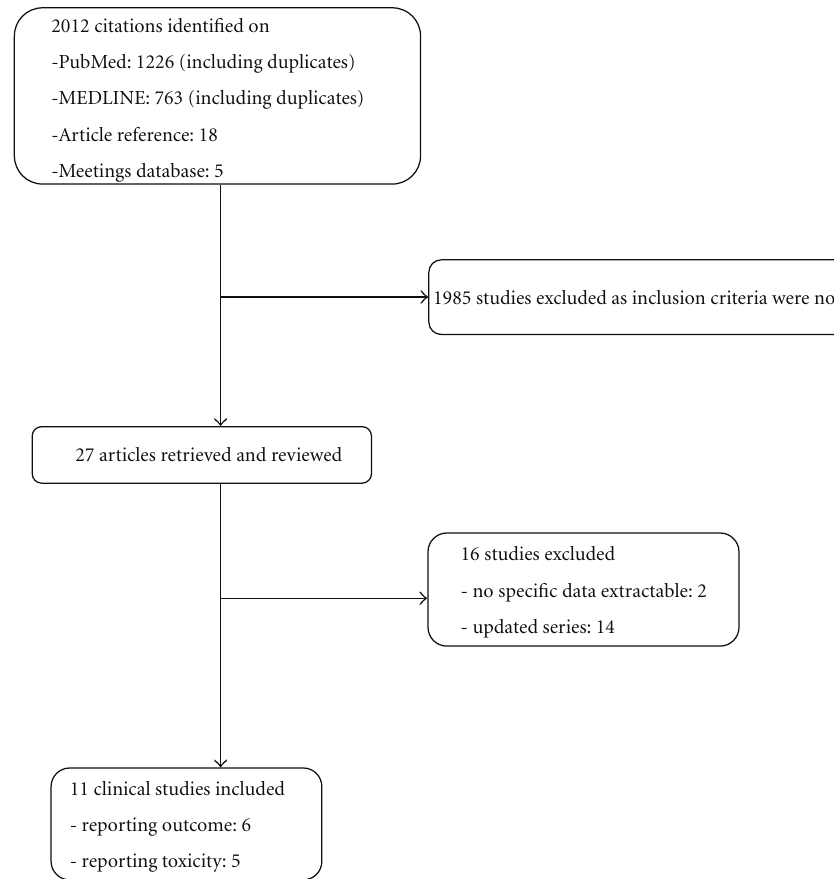
Figure 2: Flowchart of the searching